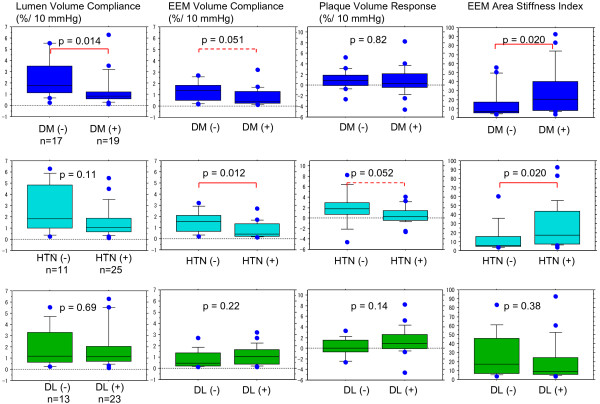
 Relationships between mechanical properties of coronary arteries and coronary risk factors. DM: diabetes mellitus, HTN: hypertension, DL: dyslipidemia. Non-parametric data was shown in box plot. A line in the box marks: median. Central box spans: 1st quartile and 3rd quartile. Lines extend from the box: 10th and 90th percentile.